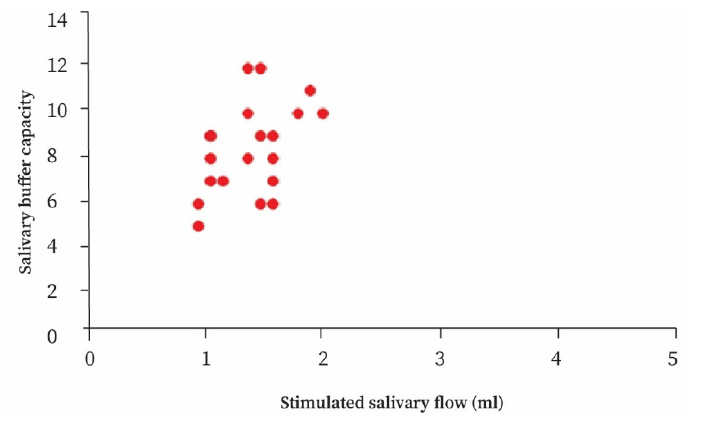
Figure 4. Dependence of the salivary buffer capacity on the ratio of stimulated salivary flow (ml/min).